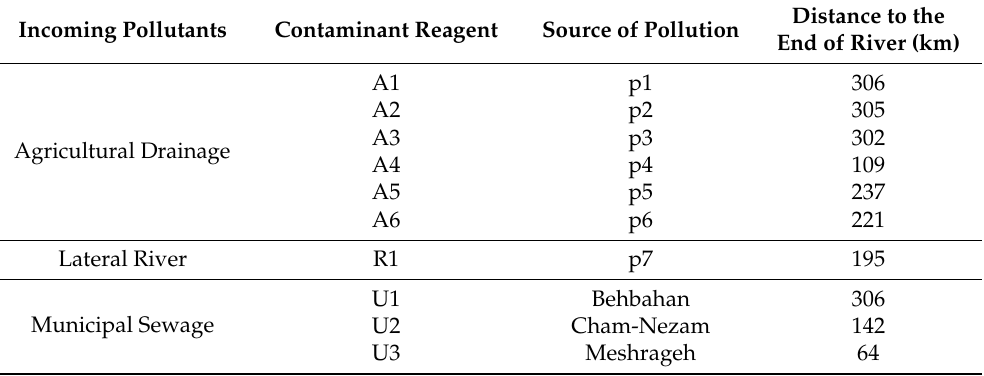
Table 5. Sources of inlet and point-source pollutants for the Maroon and Jarahi